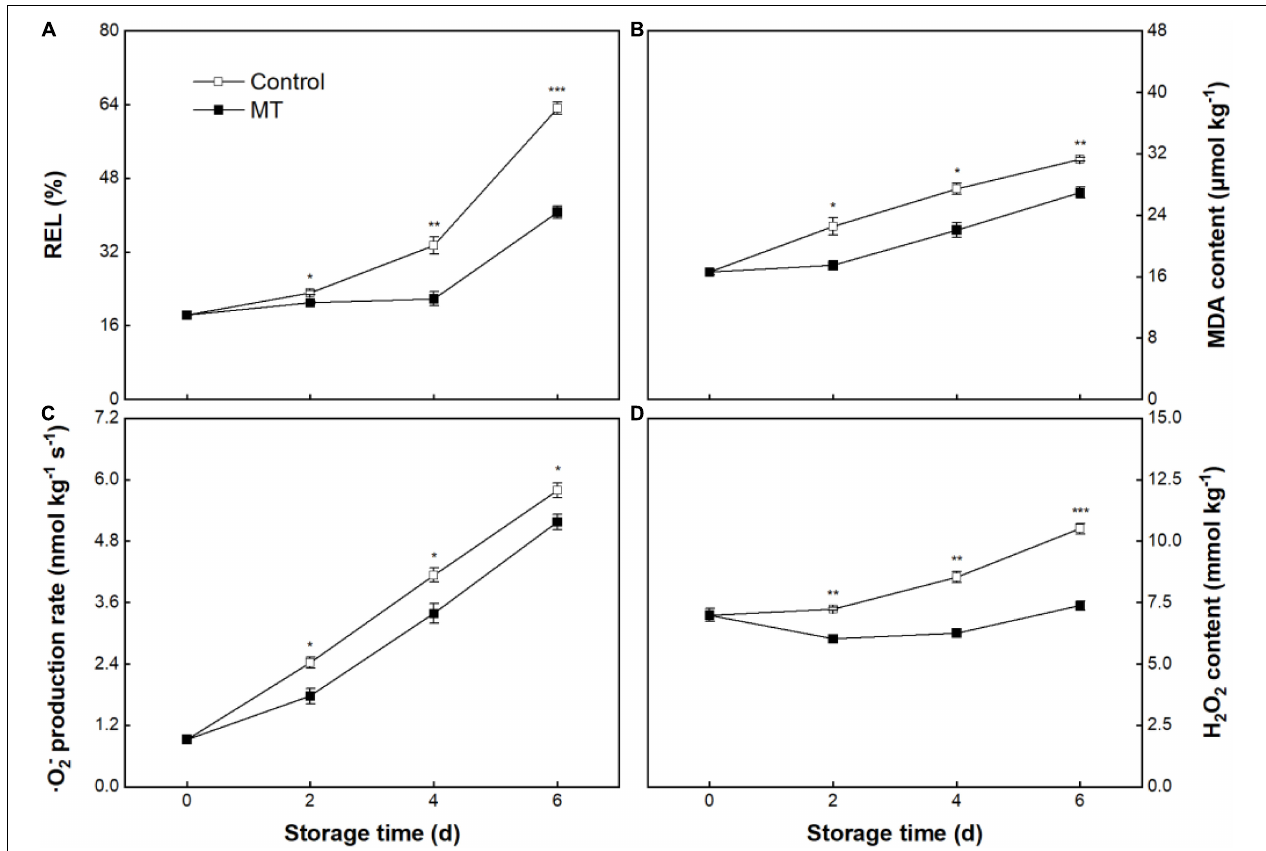
FIGURE 3 | Relative electrolytes leakage (REL) (A) , malonaldehyde (MDA) content (B) , O 2 − production rate (C) , and H 2 O 2 content (D) in “Baoyan7” rambutan fruit during storage at 25 ◦ C after treatment with 0.125 mmol L − 1 MT or water (control). The vertical lines represent the SE of triplicates while the asterisks indicate a significant difference between the MT group and the control group at the same day ( ∗ p < 0.05, ∗∗ p < 0.01, and ∗∗∗ p <